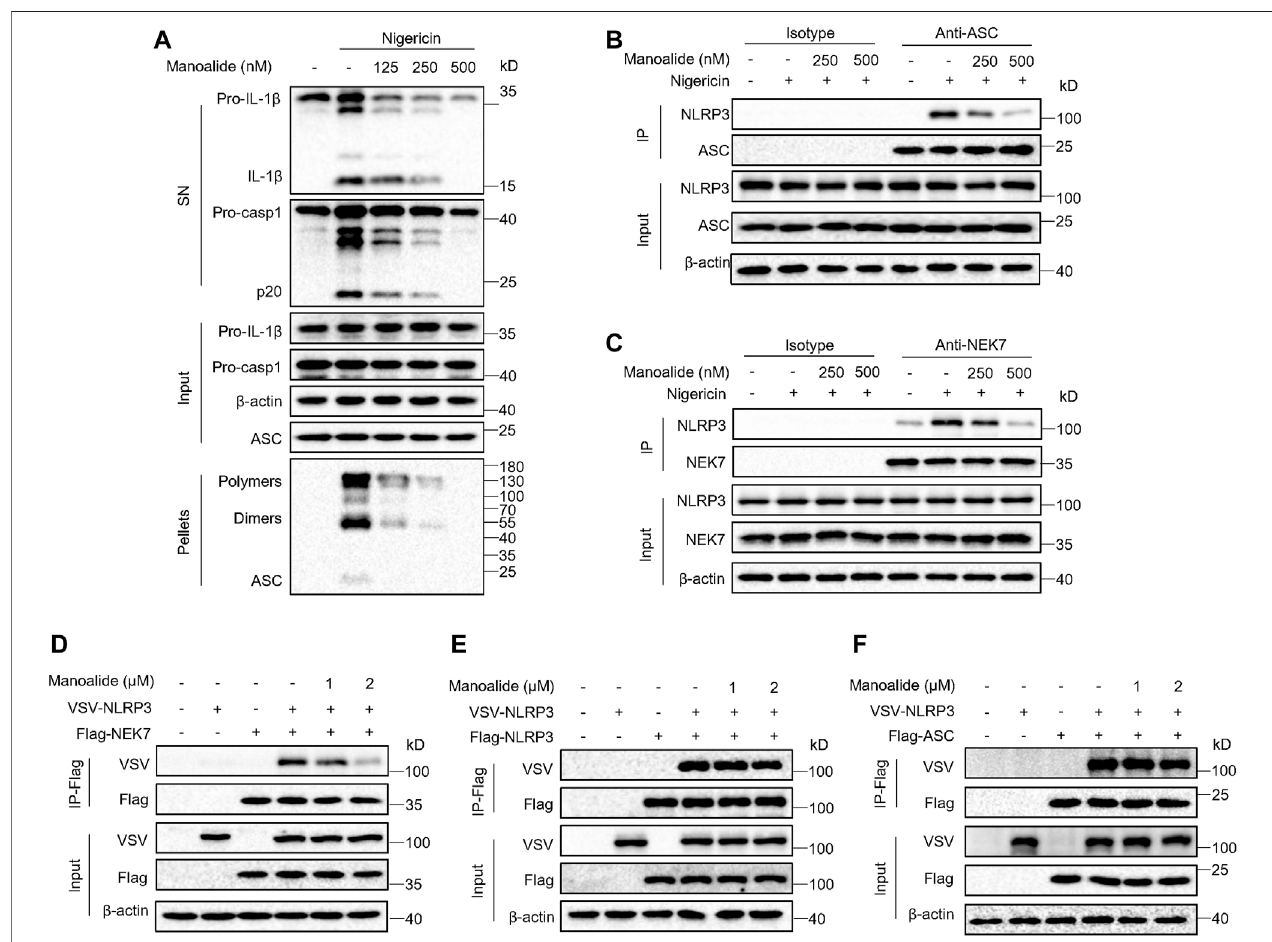
FIGURE4| ManoalideblockstheassemblyofNLRP3in fl ammasomebyinhibitingNLRP3-NEK7interaction. (A) WesternblotanalysisofASColigomerizationinthe TBS buffer-insoluble pellets and lysates of LPS-primed BMDMs pretreated with 500 nM manoalide at different doses before stimulation with nigericin. (B) Western blot analysis of endogenous immunoprecipitation with ASC-antibody or isotype antibody in LPS-primed BMDMs pretreated with 250, 500 nM manoalide before stimulation with nigericin. (C) Western blot analysis of endogenous immunoprecipitation with NEK7-antibody or isotype antibody in LPS-primed BMDMs pretreated with 250, 500 nM manoalide before stimulation with nigericin. Western blot analysis of immunoprecipitation to evaluate (D) the NLRP3-NEK7 interaction, (E) the NLRP3-NLRP3 interactionand (F) theNLRP3-ASCinteractioninthelysatesofHEK-293Tcellspretreatedwith1,2 μ Mmanoalide.Datarepresentthreeindependentexperiments (A-F) .